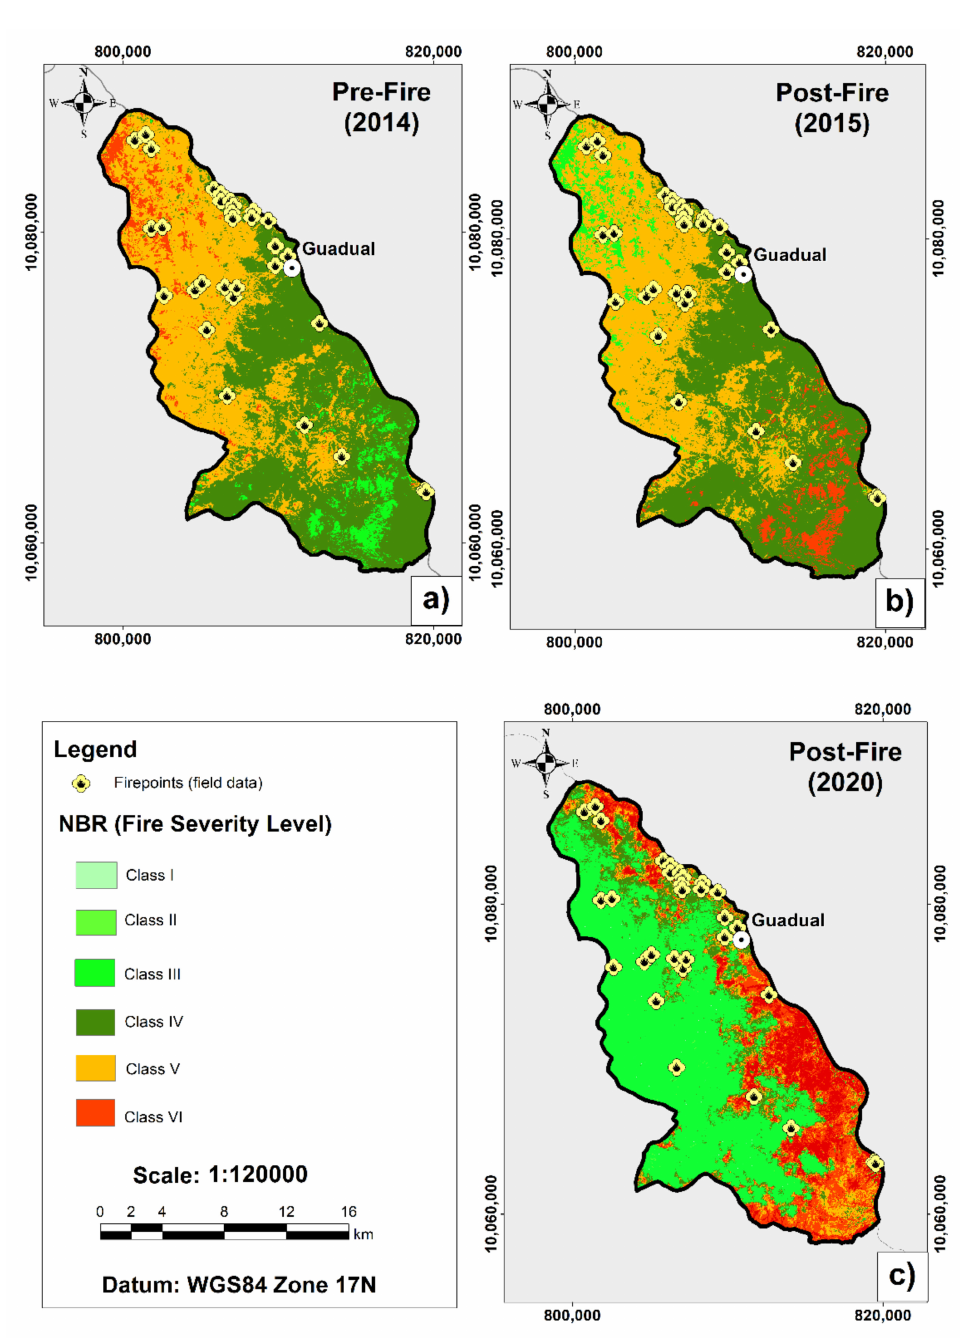
Figure 8. NBR results: ( a ) NBR pre-fire 2014, ( b ) NBR post-fire 2015, ( c ) NBR post-fire 2020, calculated with